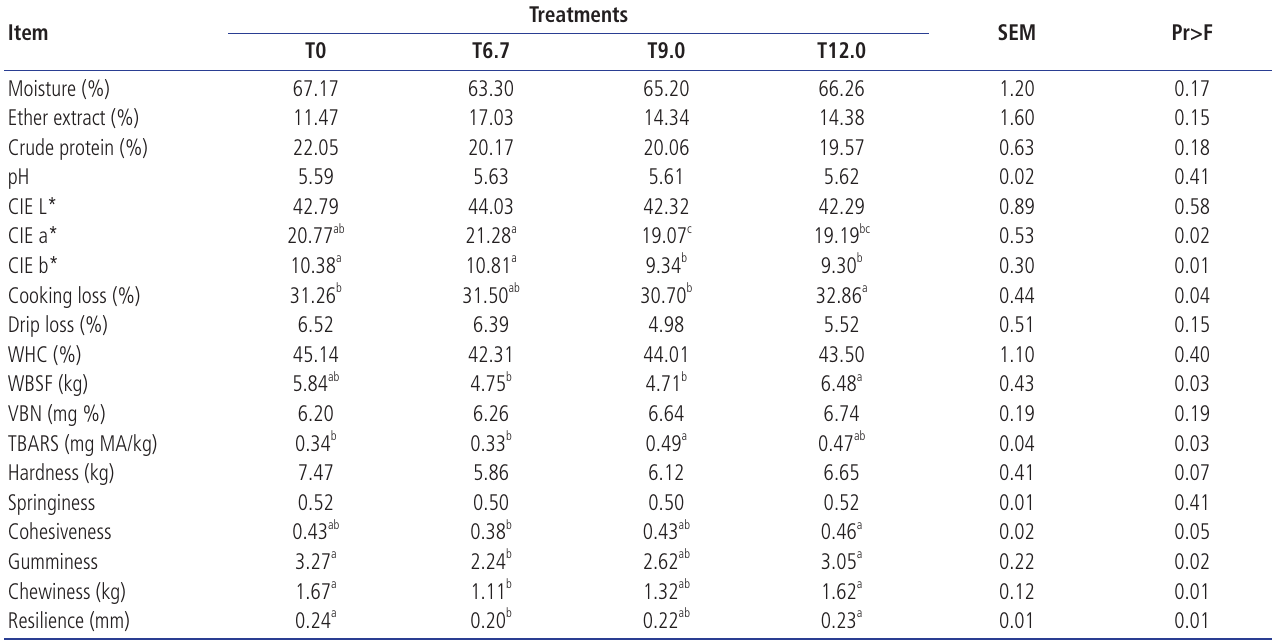
Table 6. Effects of dietary levels of tapioca residue on meat composition in the longissimus muscles of Hanwoo steers Item